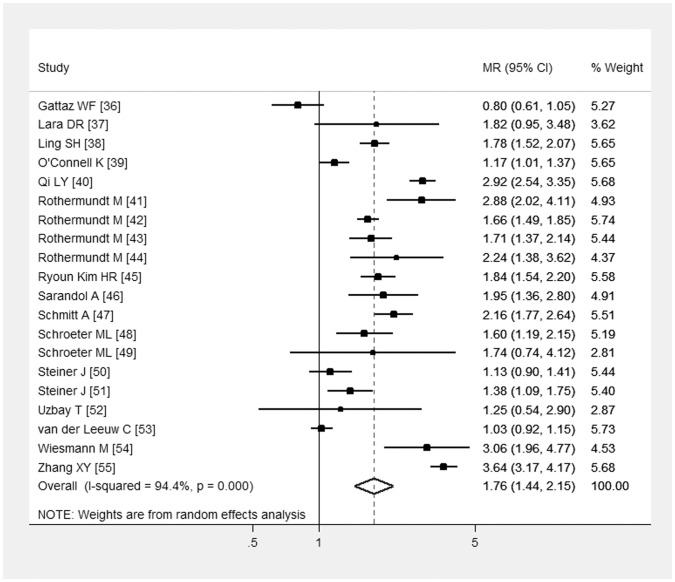
Forest plot from the meta-analysis depicting the Mean Ratio (MR) and 95% Confidence Interval (CI) of studies examining the association between S100B serum/plasma levels and schizophrenia.